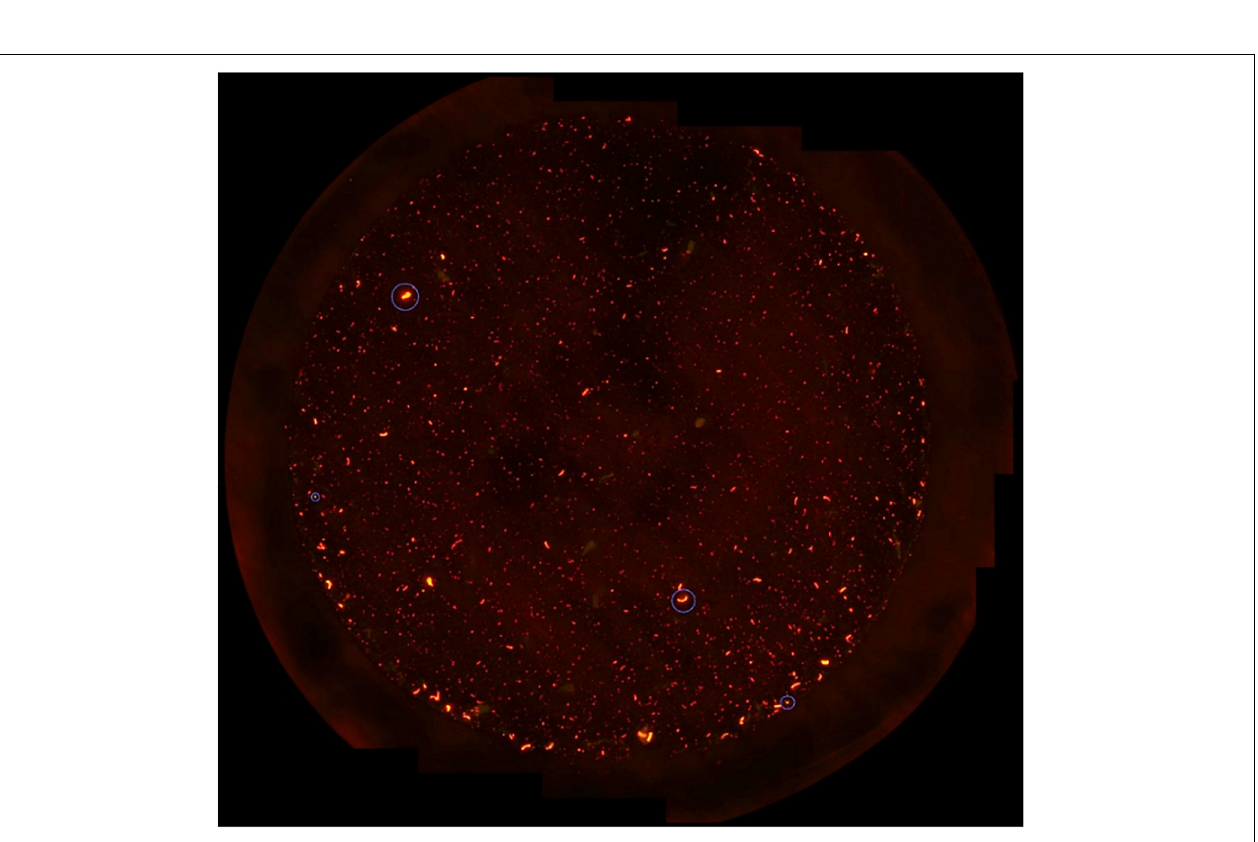
Frontiers in Marine Science |